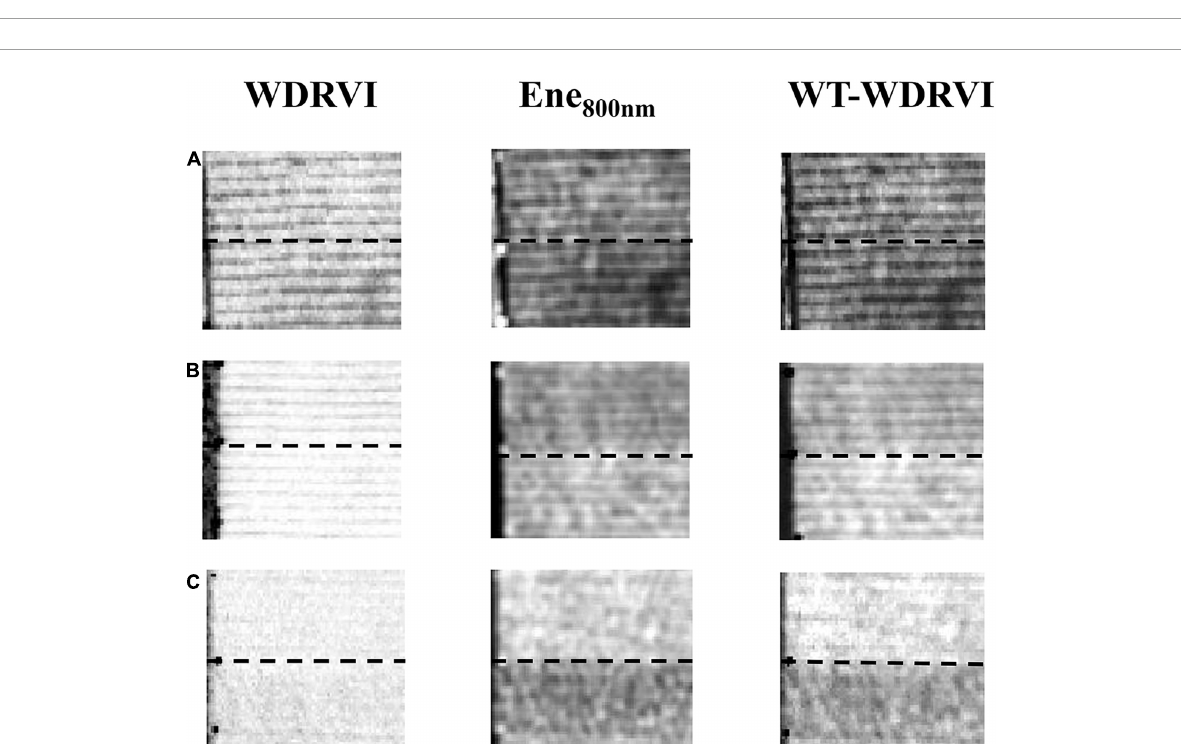
FIGURE8 WDRVI, Ene 800 nm , and WT-WDRVI images of two plots in different growth stages. (A) DAT 17, at the early tillering stage. (B) DAT 47, at the late tillering stage. (C) DAT 78, at the ripening stage. To better describe these features, two typical plots are selected to display. With the dotted line as the boundary, the upper field block is plot 1 and the lower field block is field plot